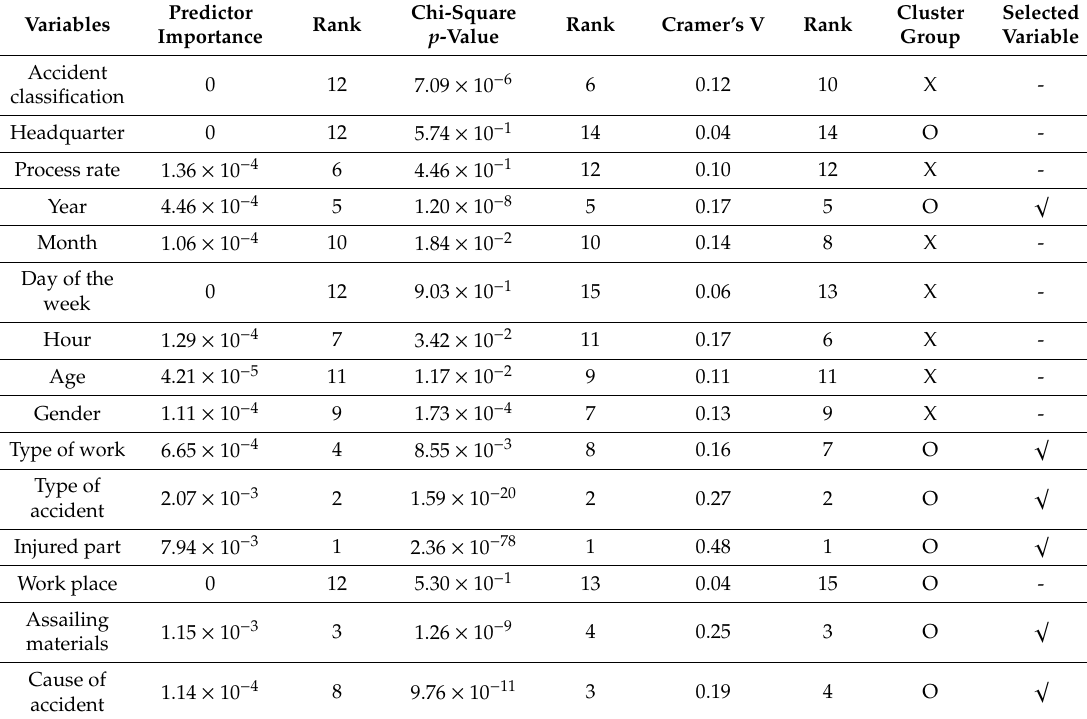
Table 3. Comparison of four methods applied to severity for extraction of major